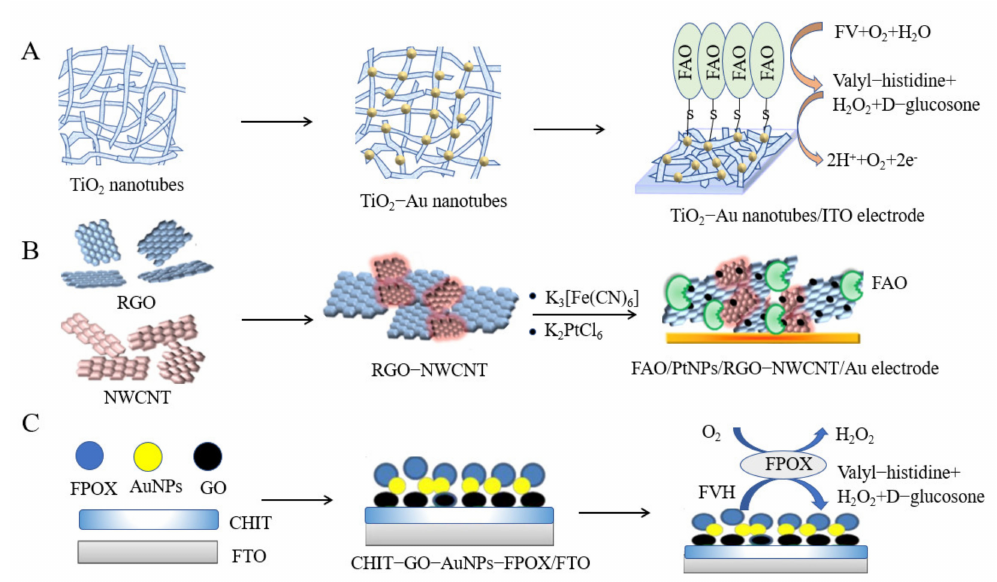
Figure 5. ( A ) An FAO/AuNP-PTA-TiO 2 nanocomposite was prepared on an ITO electrode (this figure was adapted from [92], with some modifications); ( B ) Preparation method of the FAO/PtNPs/RGO- NWCNT nanocomposite (this figure was adapted from [94], with some modifications); ( C )